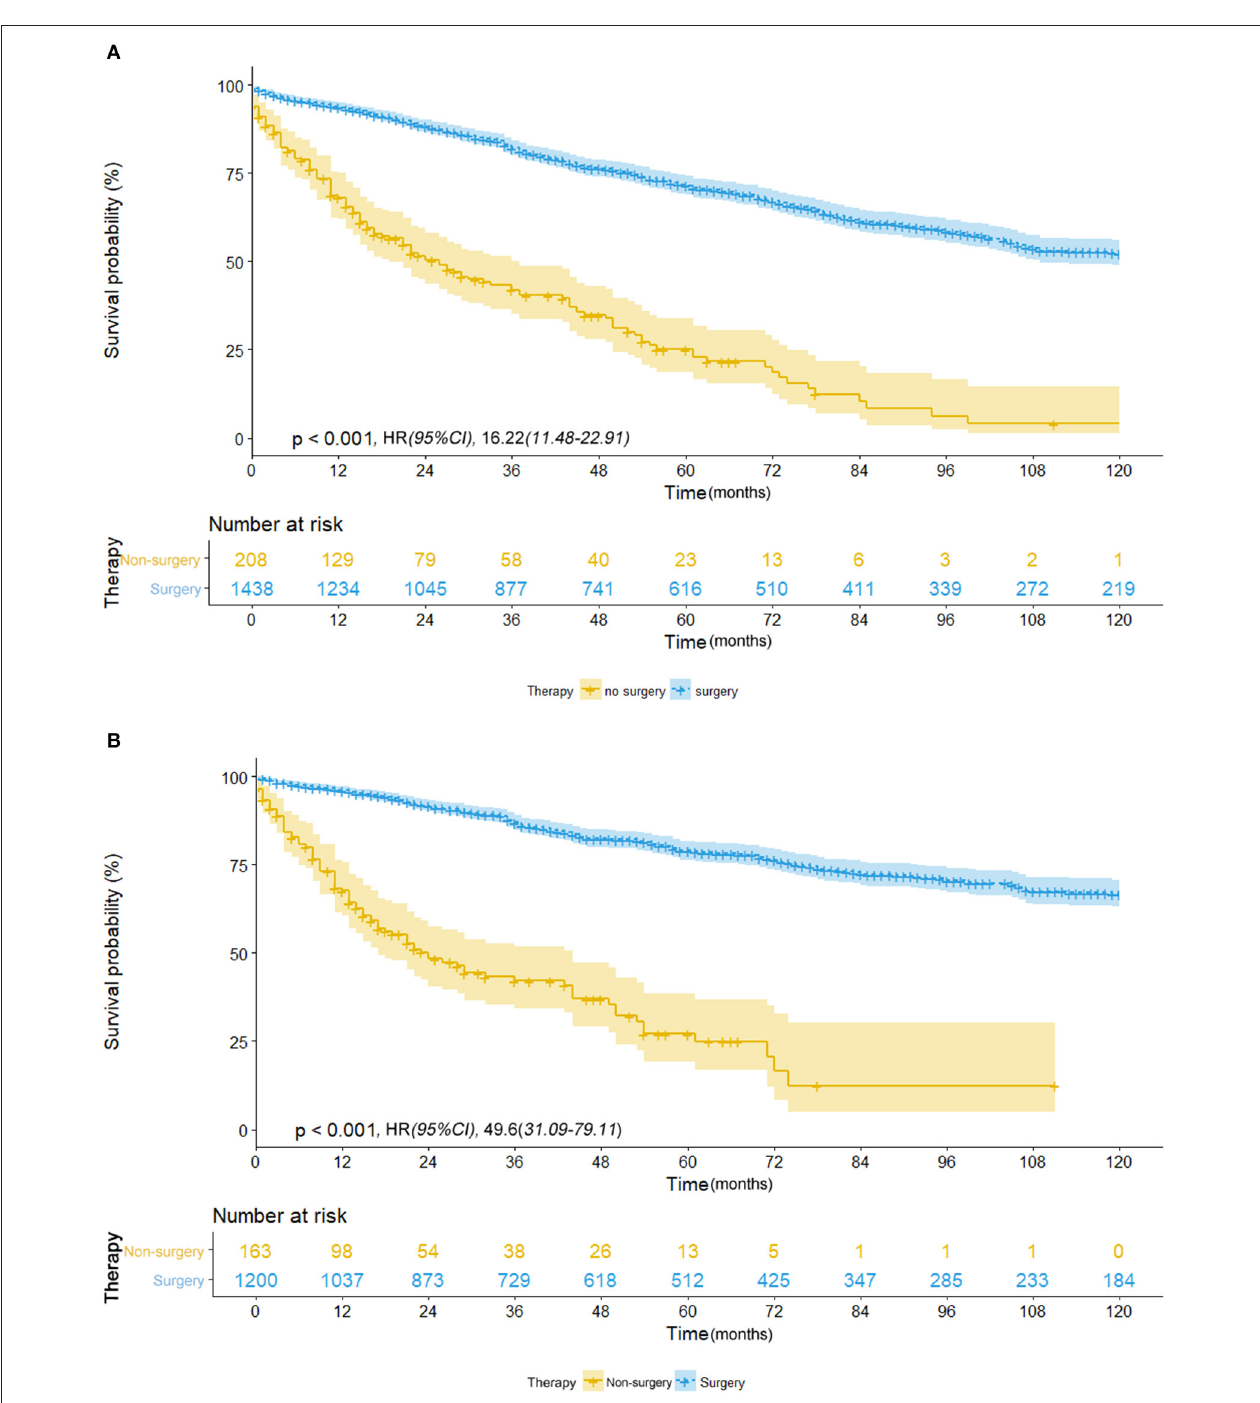
FIGURE 1 | (A) Overall survival in patients with NSCLC ≤ 8mm who received surgical treatment (blue line) vs. non-surgical treatment (yellow line) before propensity score matching. (B) Cancer-specific survival in patients with NSCLC ≤ 8mm who received surgical treatment (blue line) vs. non-surgical treatment (yellow line) before propensity score